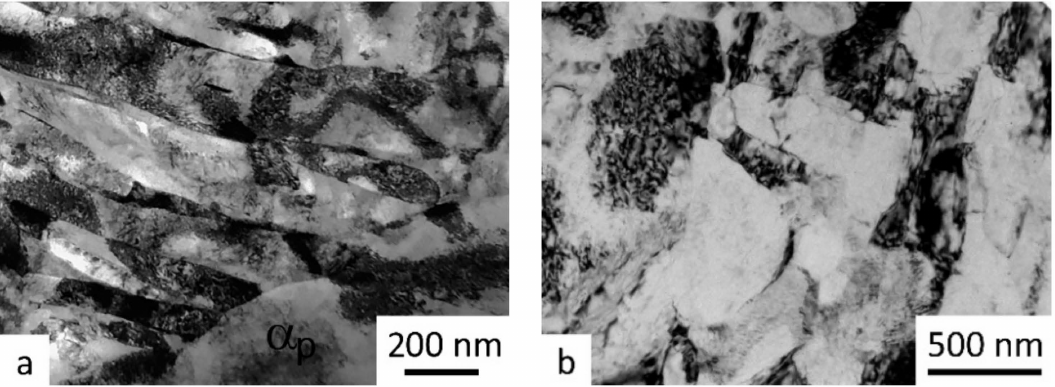
Figure 6. TEM images of the microstructure of the Ti-6Al-4V alloy samples after fatigue tests: ( a ) CG state at a stress of 700 MPa, ( b ) UFG state at a stress of 700 MPa.